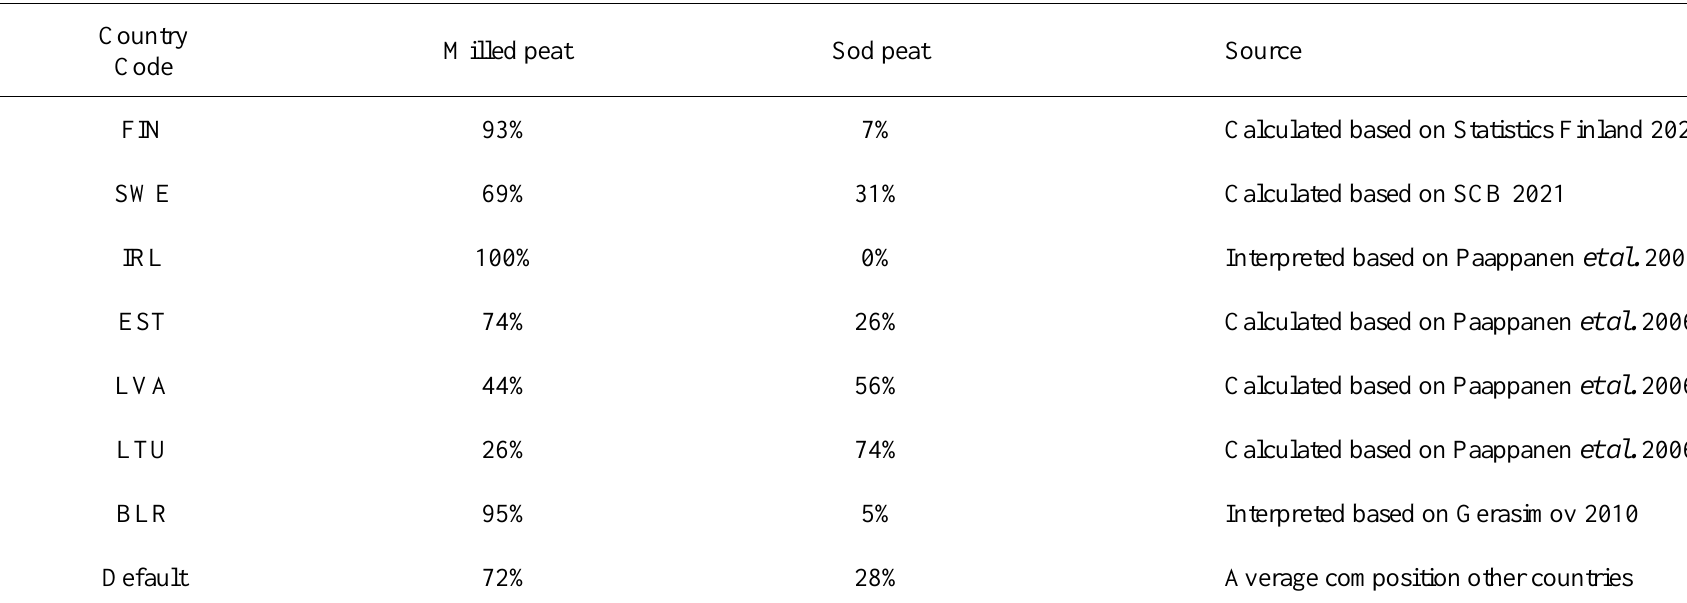
Table A4. Composition of extracted energy peat used in the model in mass